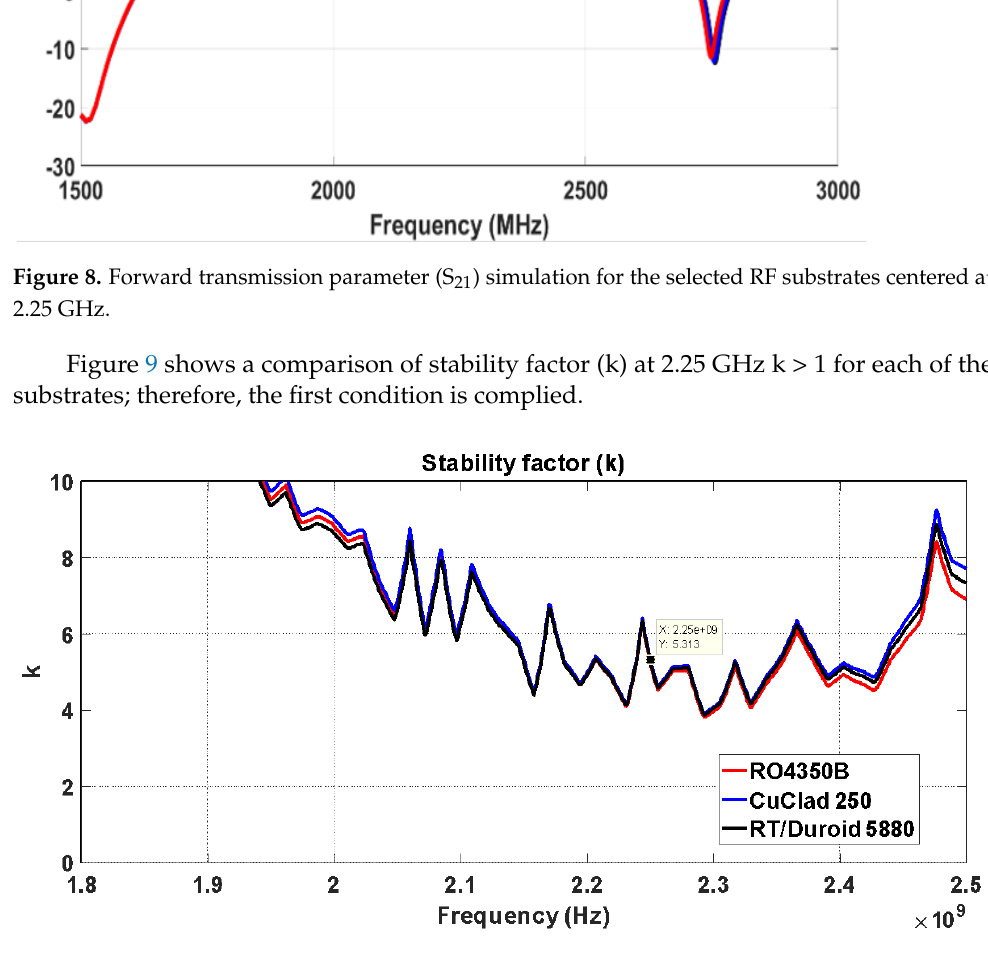
Figure 9. Stability factor (k) simulation for the selected RF substrates at 2.25 GHz.